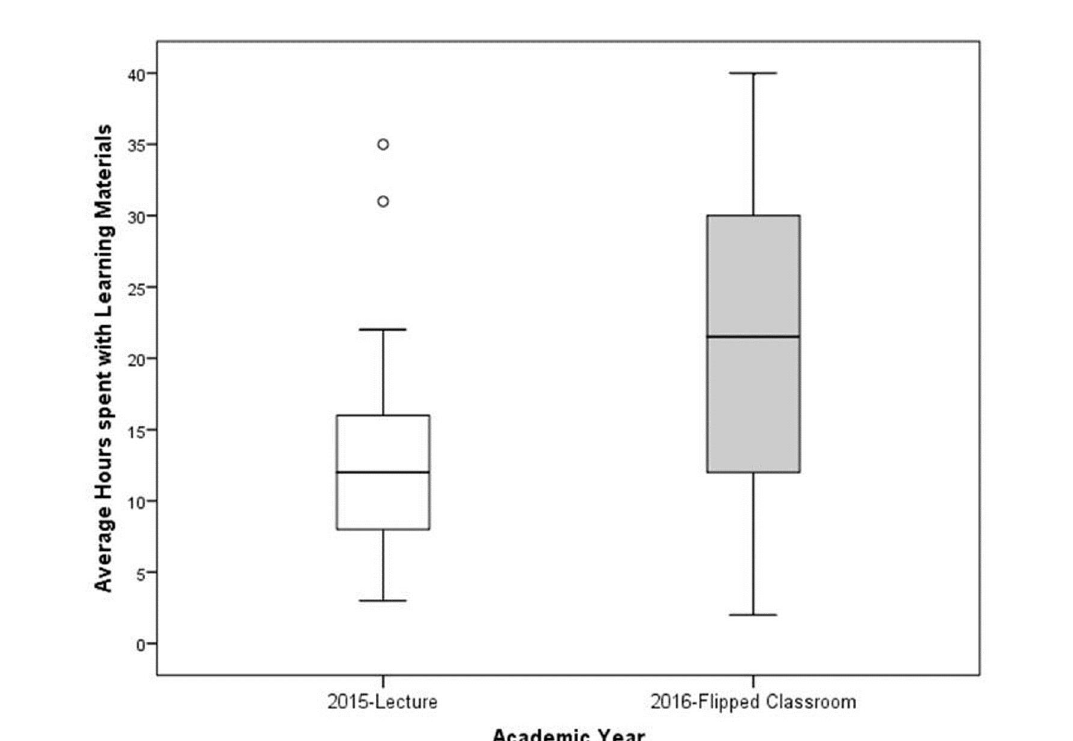
Figure 2. Box and whisker plot comparing average hours spent with outside learning materials such as textbooks, online learning resources and journals across two groups of residents: one from a lecture-based curriculum year (2015) and one from a flipped- classroom curriculum (2016).